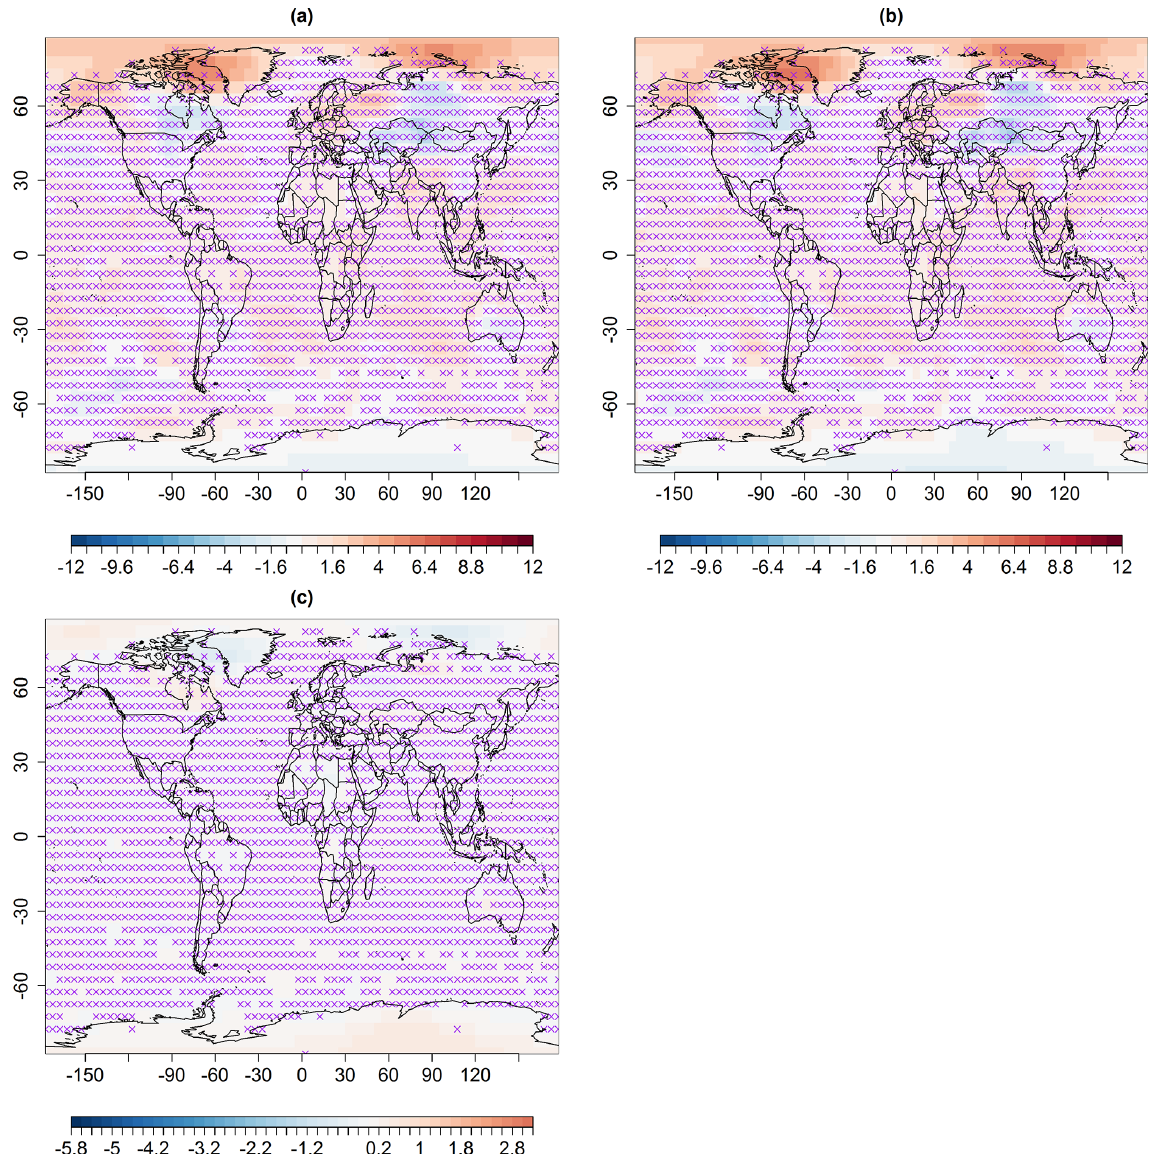
Figure B3. Spatial predictions (in degrees Celsius) for February 1988, using multi-resolution lattice kriging, based on (a) ABC, using a variogram (Sect. 2.1), and (b) the profile maximum likelihood approach (Nychka et al., 2015) used to create data in Ilyas et al. (2017). (c) The difference in panels (a) and (b) , i.e., (a) – (b) . The × signs show observed spatial sites